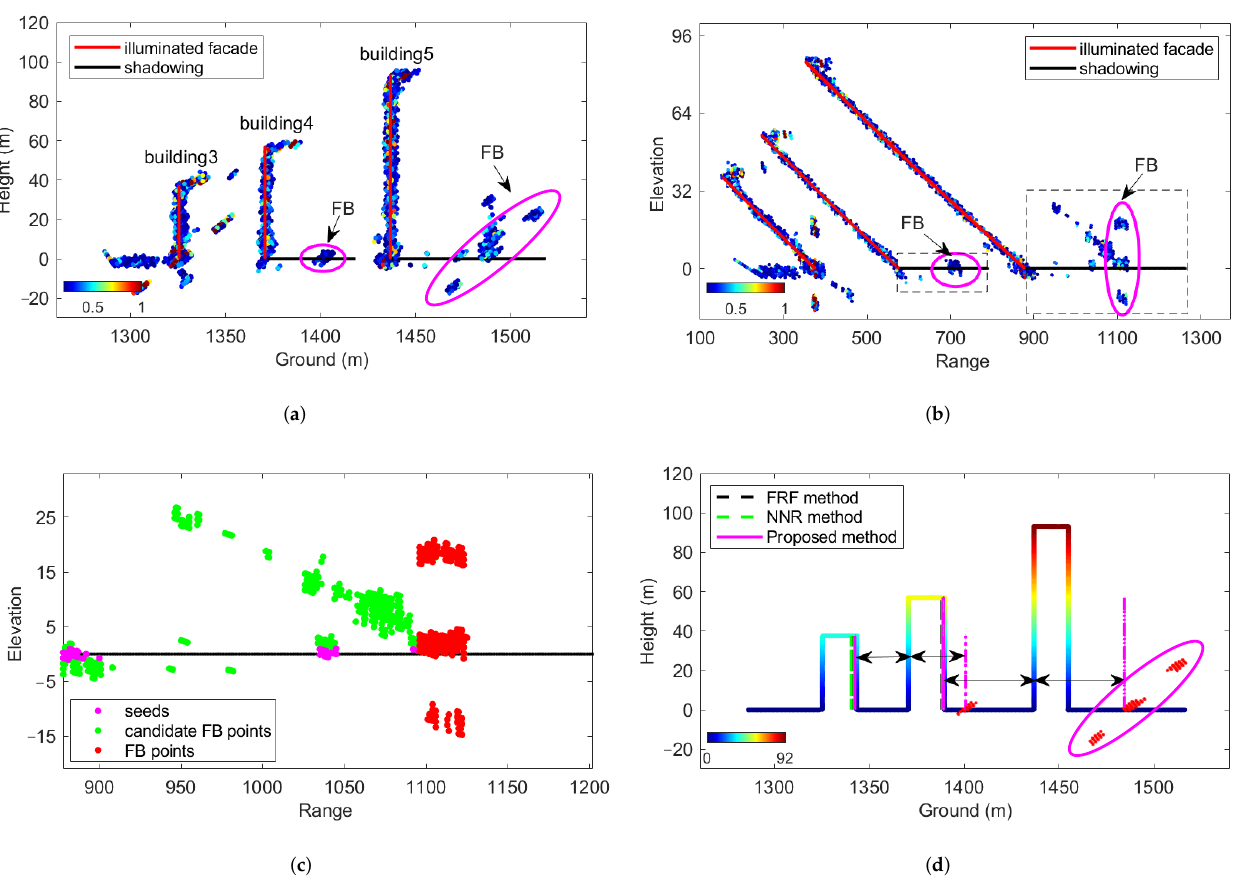
Figure 18. Illustration of the whole reconstruction process of the back of buildings of Slice 2 in Experiment 2. TomoSAR point cloud and the candidate FB scattering point detection in ( a ) the ground–height plane and ( b ) the range–elevation plane. ( c ) Detection of FB scattering point in range–elevation plane. ( d ) Reconstruction results of the back of buildings 3 and 4, where the line colored by height indicates the reference true